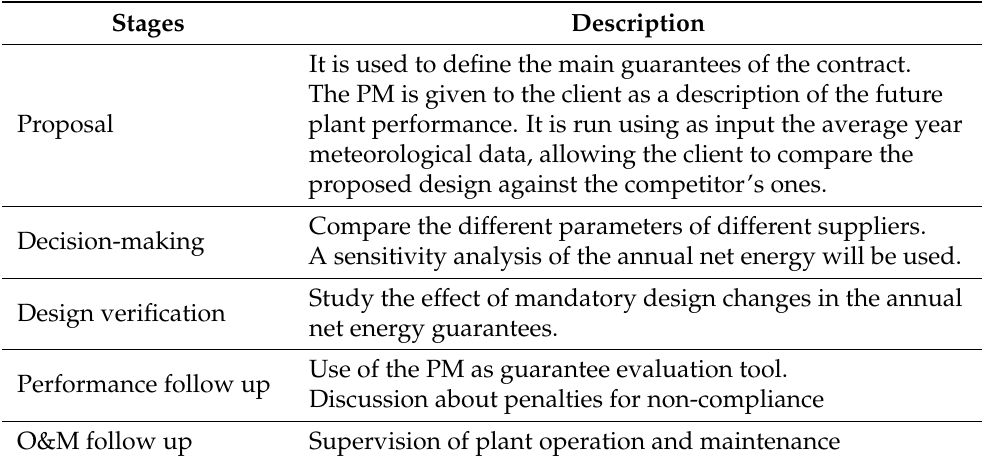
Table 1. Uses of PM in the CSP plant project